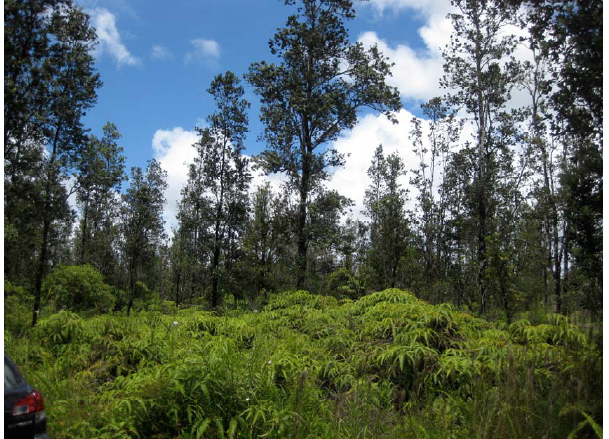
Fig. 4. Mature Metrosideros forest with Cibotium tree fern undergrowth in lowland near Kalapana, Hawai`i Island. Broomsedge grass ( Andropogon virginicus ) in foreground (photo by D. Mueller-Dombois, 1984).